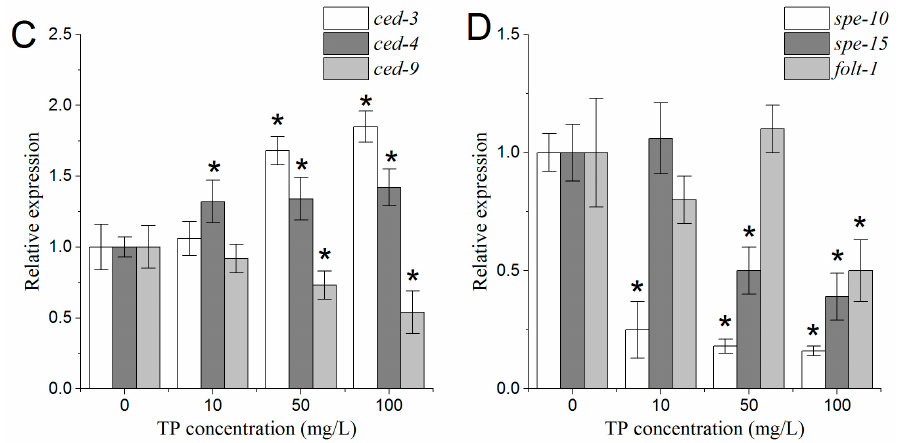
Figure 10. Relative mRNA expression levels of genes involved in gametogenesis of L4 larval nematodes exposed to TP. Gene expression was analyzed at 24 h after the exposure: ( A , B ) relative mRNA expression levels of genes involved in mitotic germ cell proliferation and oocyte quality; ( C ) relative mRNA expression levels of genes involved in apoptosis; and ( D ) relative mRNA expression levels of genes involved in spermatogenesis. TP, Triptolide. Bars represent means ± SEM. * p < 0.05 vs. the control group.